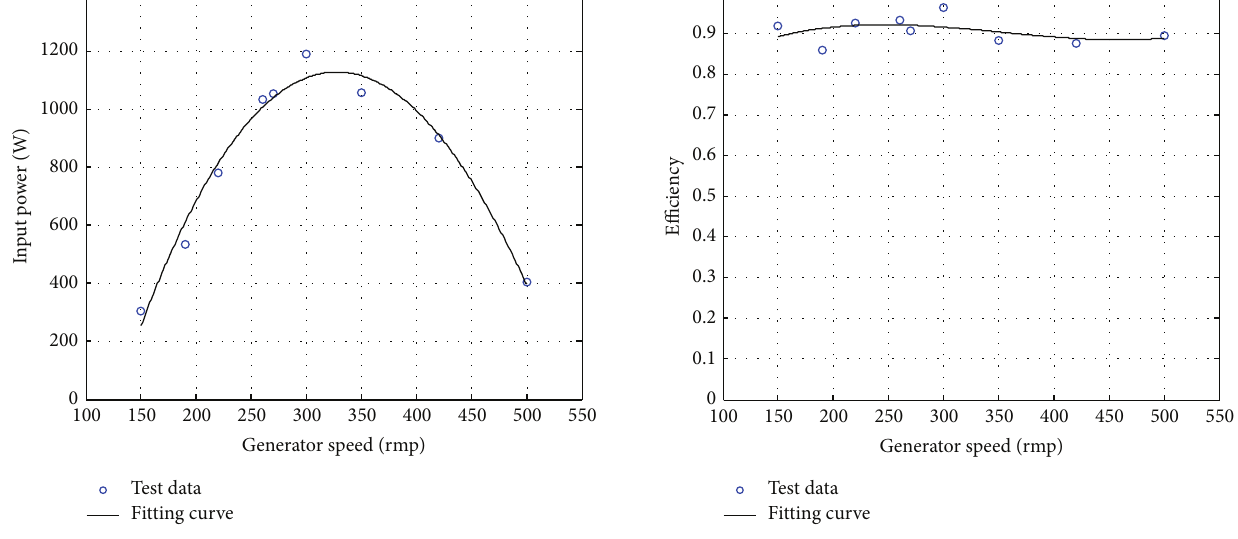
Figure 12: The efficiency of Buck converter versus generator speed.